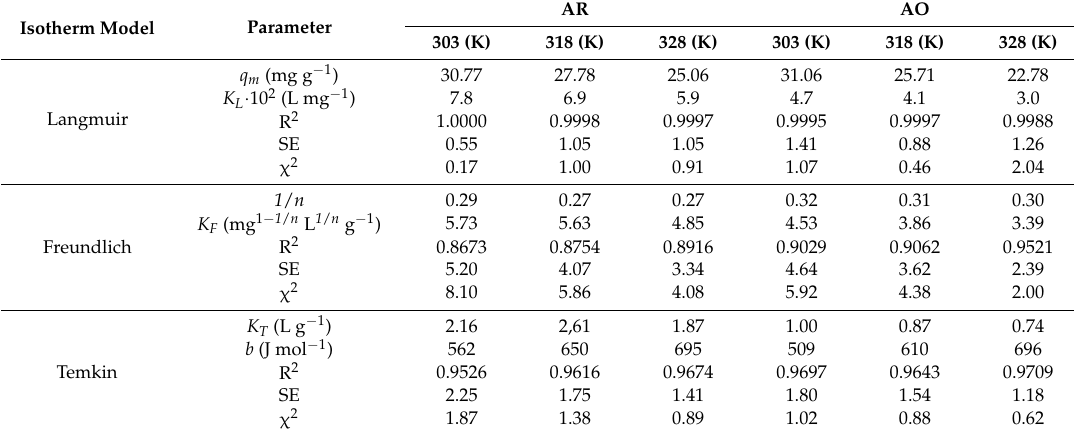
Table 3. Comparison of the isotherm models.